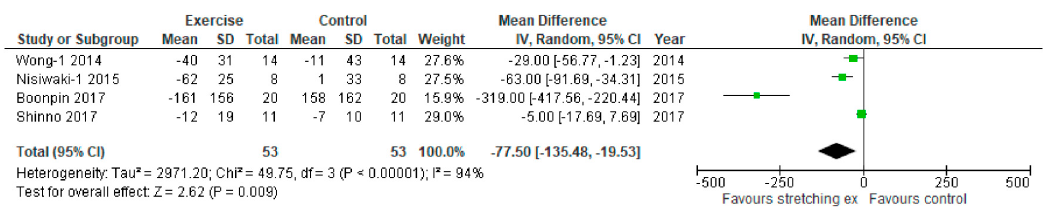
Figure 5. Sensitivity analysis with only studies using baPWV comparing changes in arterial stiffness following stretching exercises to non-exercise controls (sensitivity analysis-3 for primary outcome). IV, inverse variance; CI, confidence interval; Std, standardized.